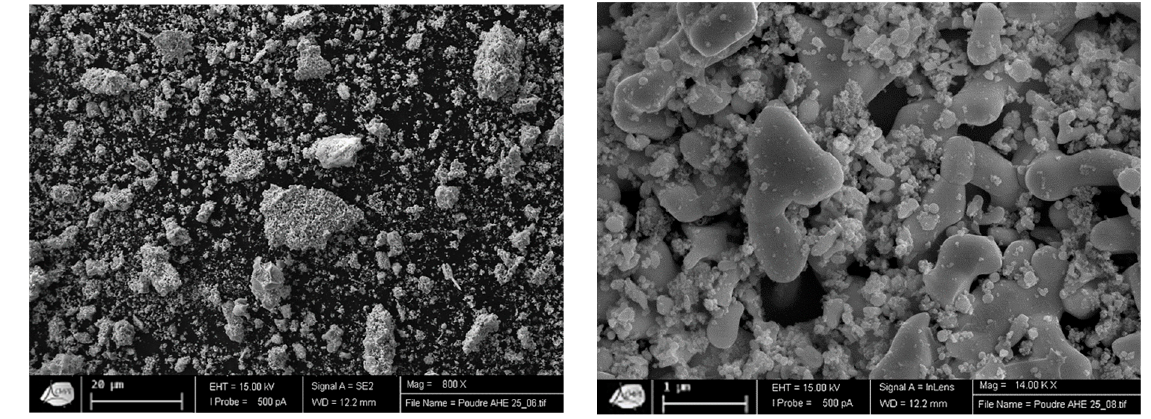
Figure 3. Scanning electron microscope observation of WmoTaNb powder in backscattered elec ‐ trons.